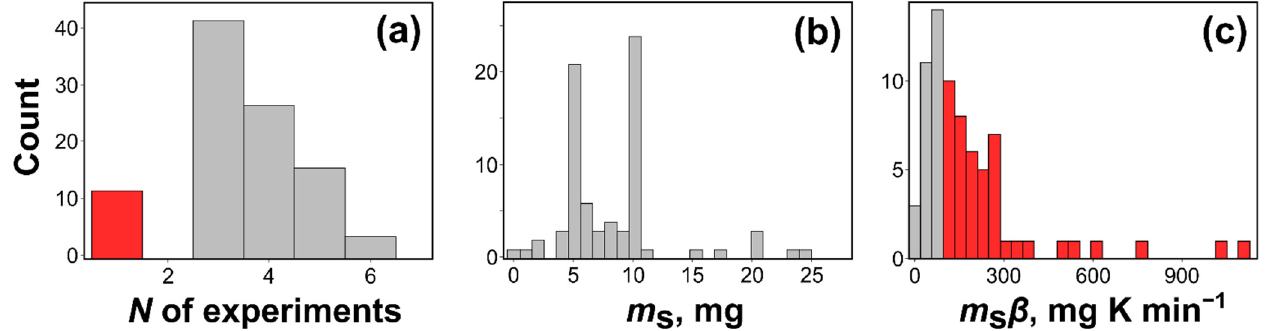
Figure 8. Summary of the experimental details extracted from the top 100 by citations thermokinetic papers from 2021: ( a ) number of experiments used in kinetic analysis, ( b ) distribution of the sample masses used to measure thermal analysis data, ( c ) the product of sample mass and heating rate for nonisothermal data from the dataset.